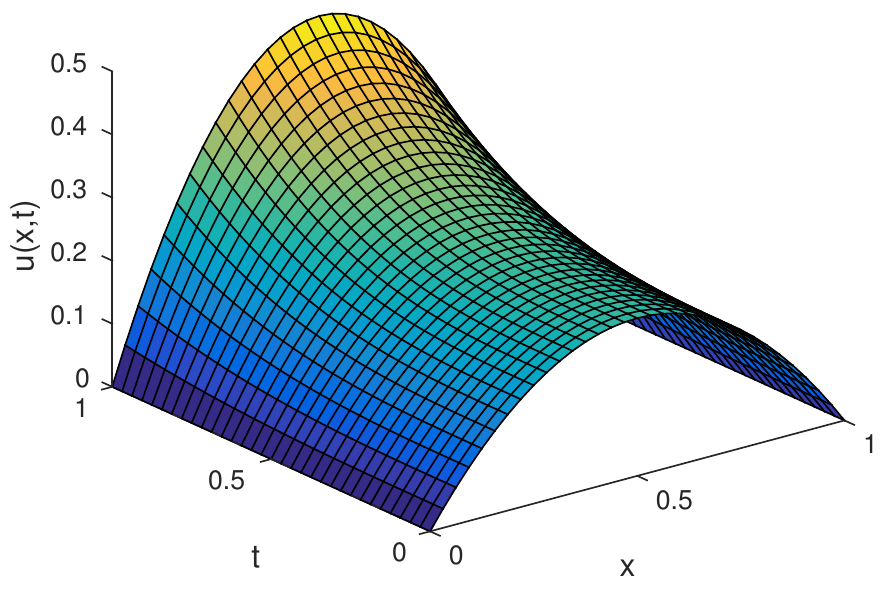
Figure 1. Numerical solution of the problem (74) using L = T = 1 and α = 1 presented in this work with computational parameters h = 0.01 and τ =